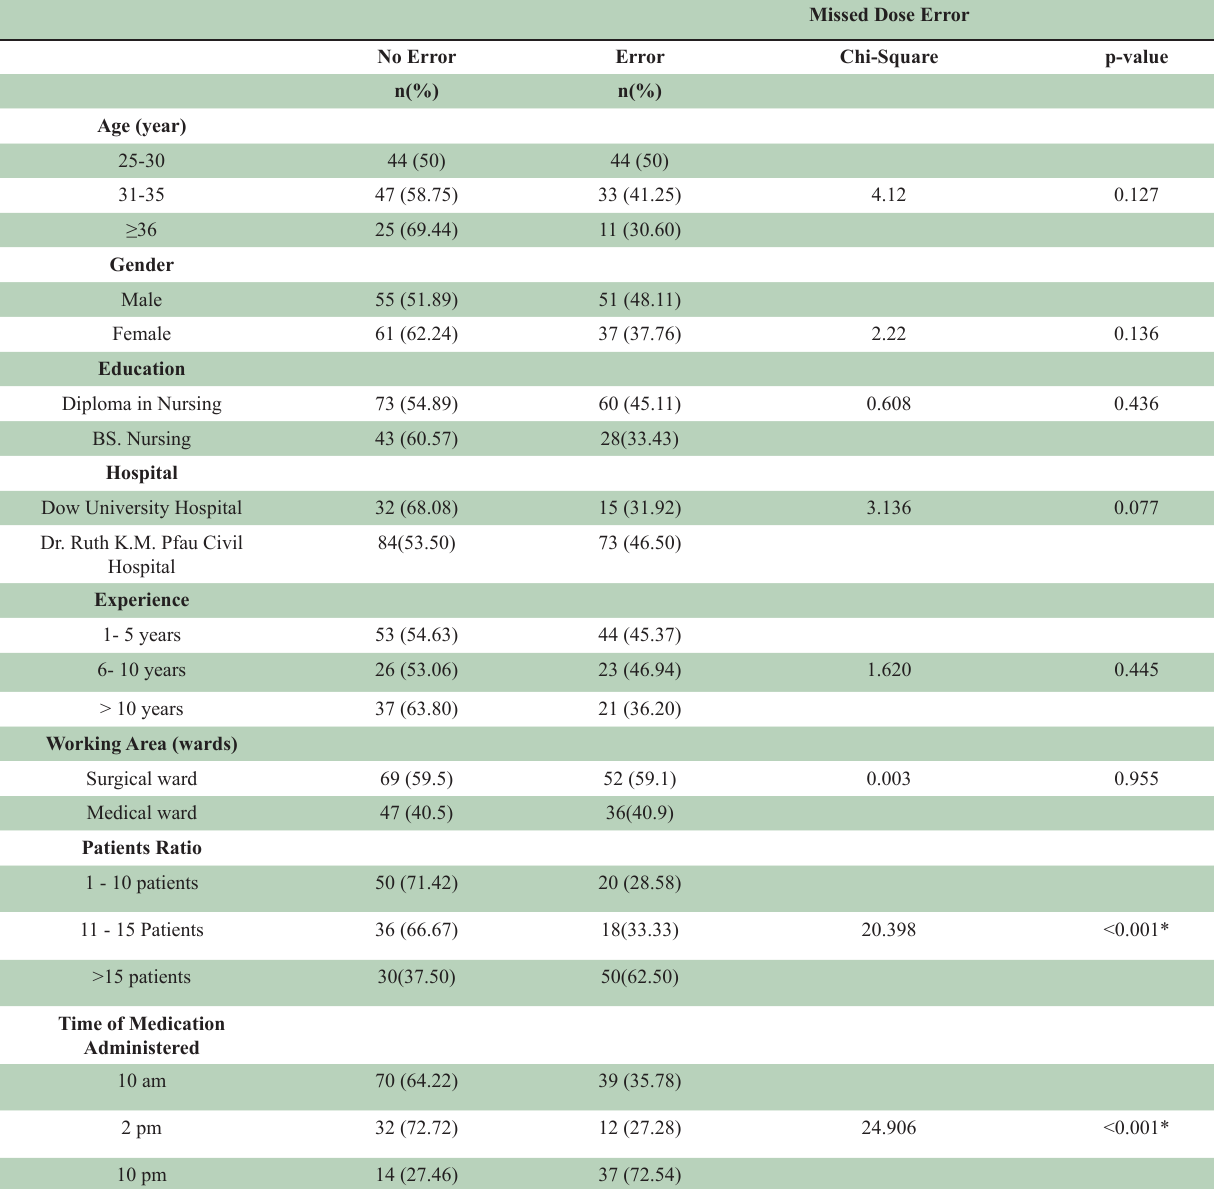
Table-I: Association of Missed Dose Error with Socio-demographic Characteristics of the Participants (n=